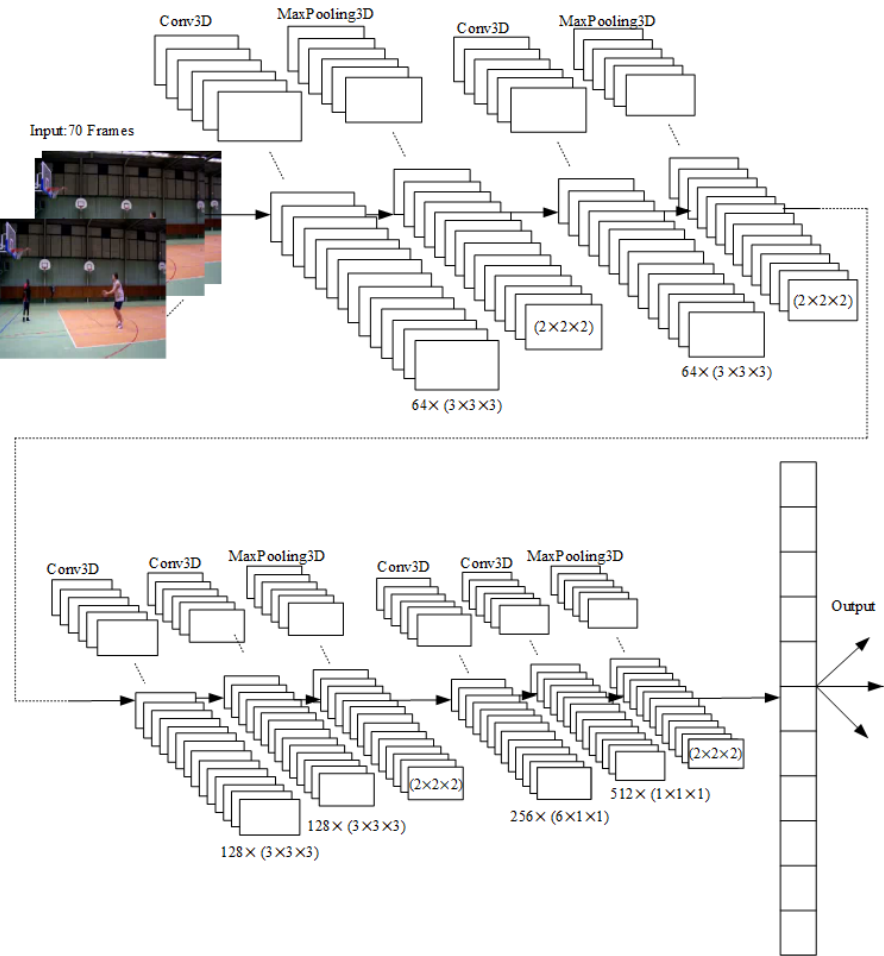
Figure 3. Proposed 3DCNN